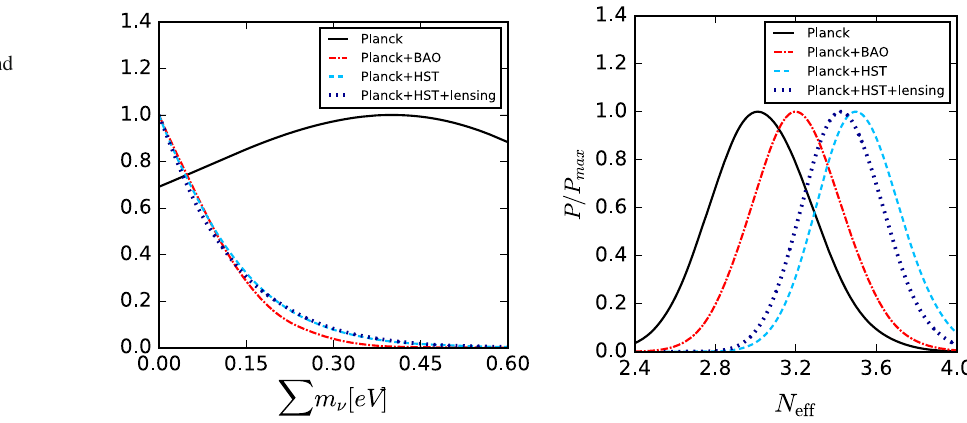
Fig. 8 Comparison of 1-D marginalized posterior (cid:2) m ν (eV) and distributions for N eff for various data combinations in NPDDE11+ A lens